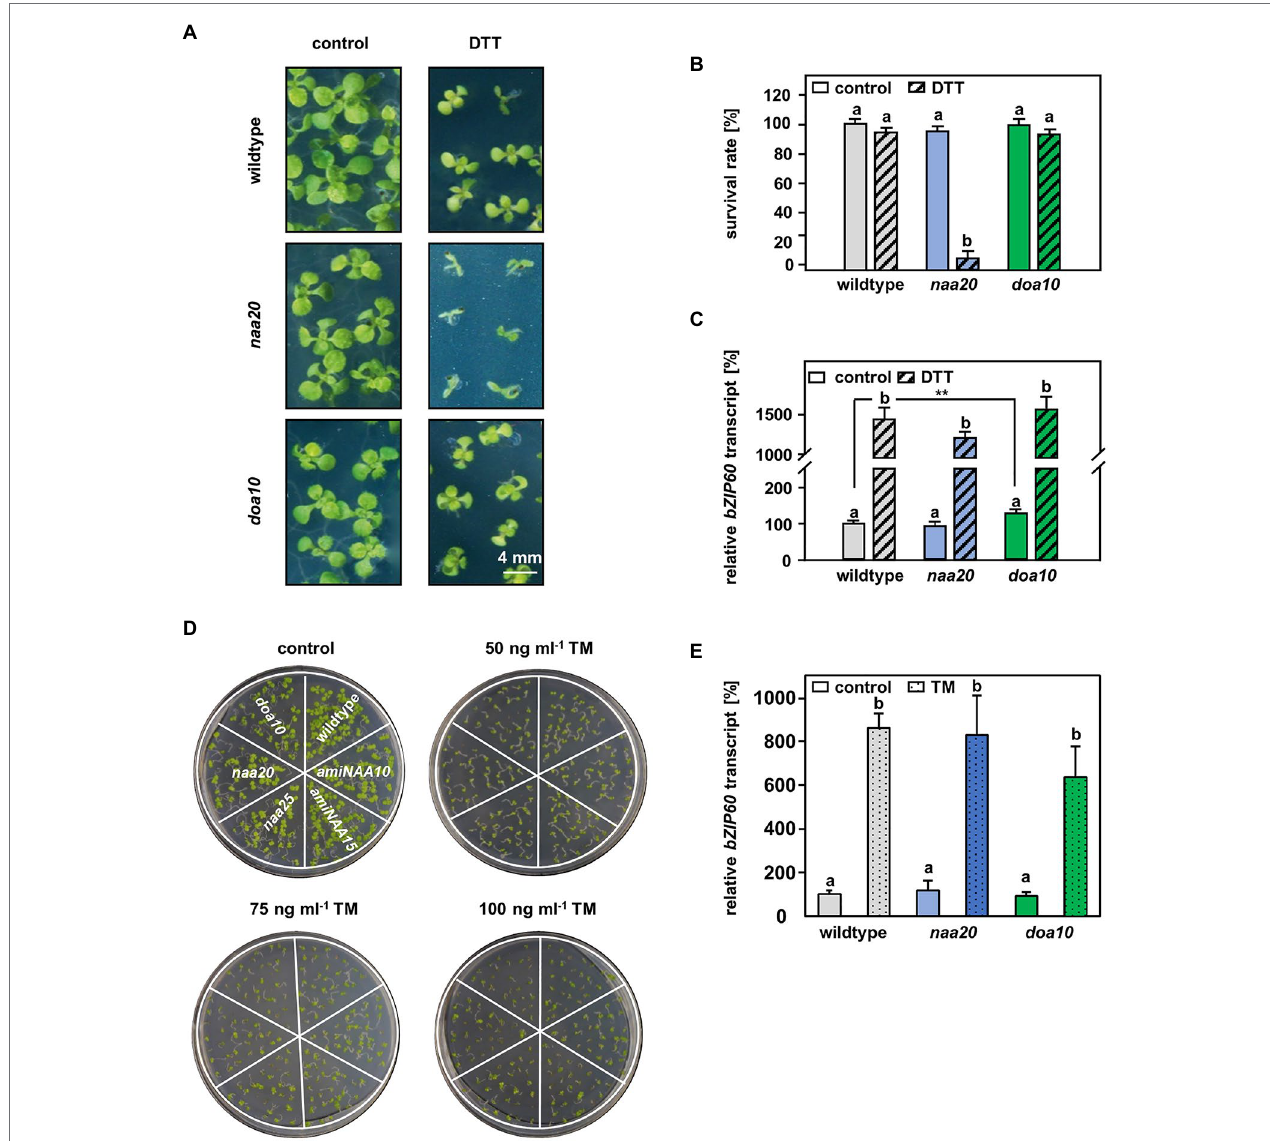
FIGURE 4 | The connection between DOA10 and NAA20 mediated N-terminal acetylation. (A) Representative depiction of the seedlings after 3 weeks of growth on 1 x MS medium with and without 2.5 mM DTT ( n = 3, 1n ≥ 29 seeds) (scale bar = 4 mm). (B) Quantification of living seedlings as shown in A. (C) Relative bZIP60 transcript level in ten-day-old seedlings after 5 h of incubation in liquid 1 x MS medium (control) supplemented with 10 mM DTT (DTT). (D) Representative depiction of the seedlings after 10 days of growth on 1/2 x MS medium supplemented with 0, 50, 75, or 100 ng/ml tunicamycin (TM). (E) Relative bZIP60 transcript level determined in six-day-old seedlings after 5 h of incubation in liquid ½ MS medium containing 5 μ g/ml tunicamycin or and equivalent volume of DMSO (control). Data given as means ± SE. Different letters indicate individual groups identified by pairwise multiple comparisons with a Holm-Sidak, One-way ANOVA ( p <